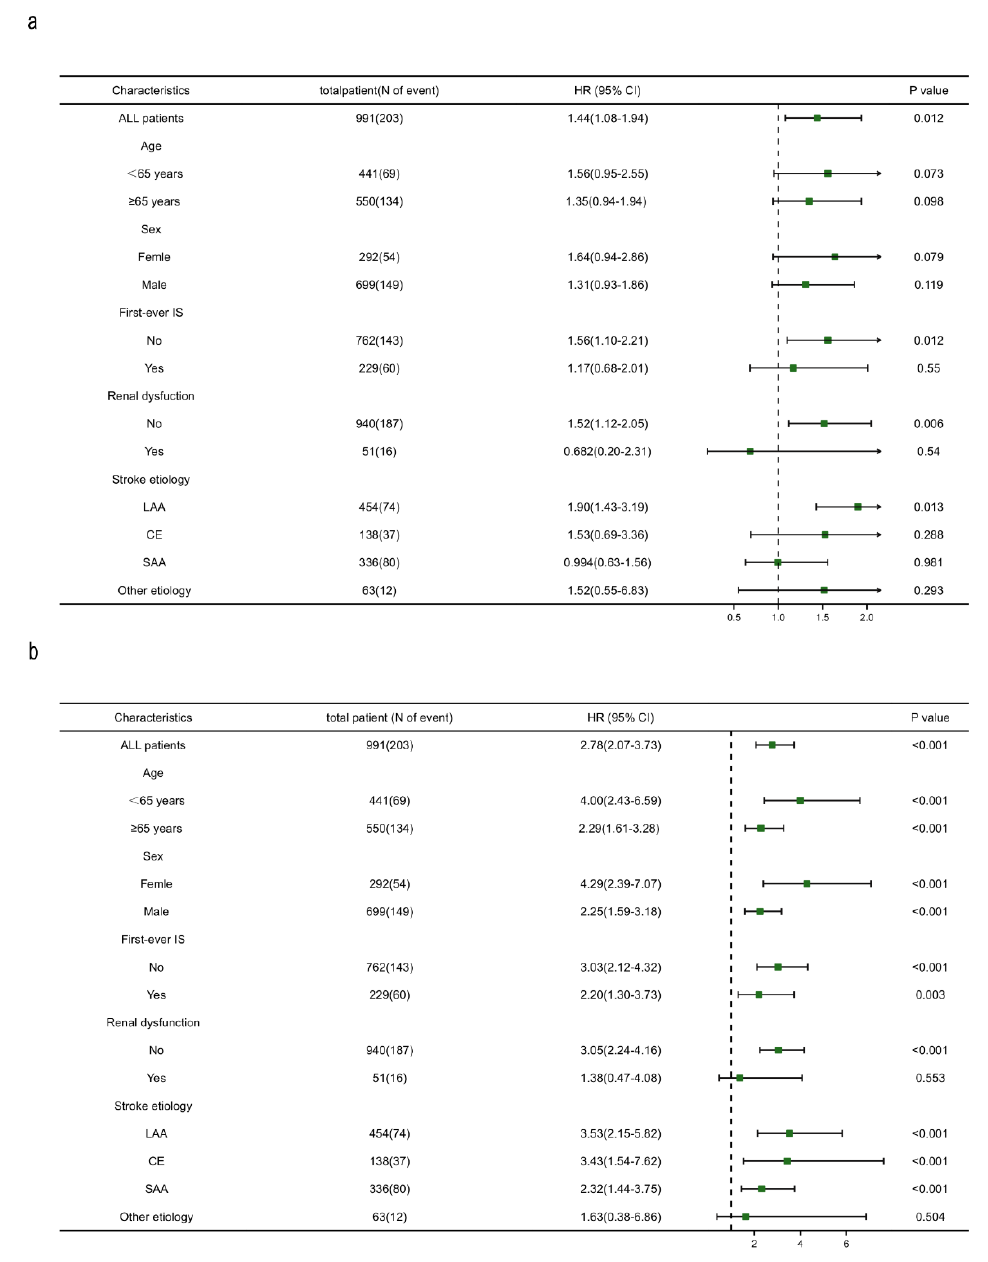
Figure 4. Cox regression analysis adjusted for covariates included in Model 3 in Table 3 were used to examine the association of the malnutritional index (CONUT > 1 versus CONUT ≤ 1, ( a ); PNI ≤ 44.75 versus PNI > 44.75), ( b ) among different subgroups.